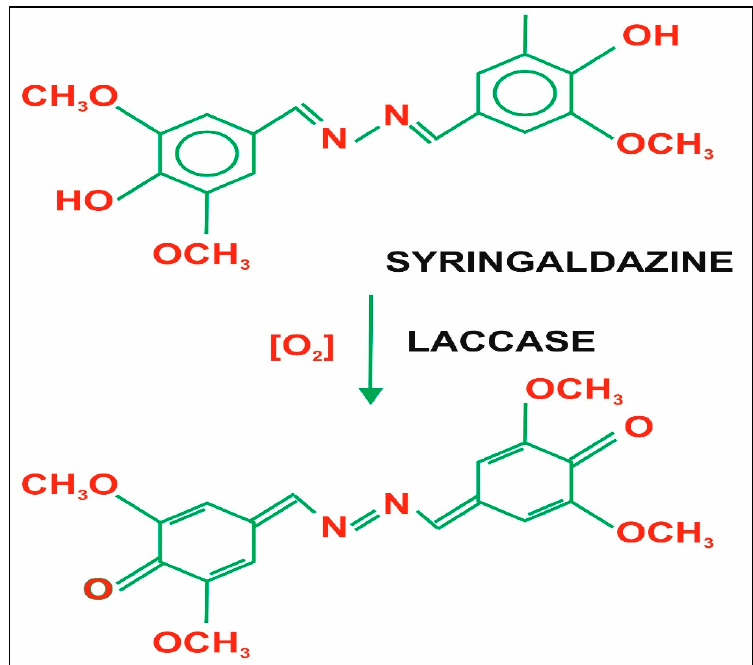
Figure 3. Structure of the substrate syringaldazine [55].